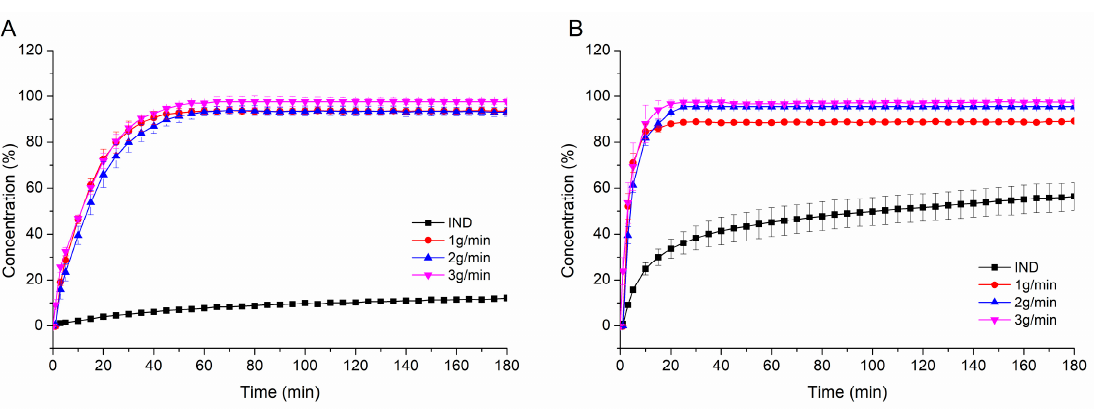
Figure 8. Non-sink dissolution of indomethacin (IND)-PVAP ASDs for different hot-melt extrusion (HME) process conditions at pH 5.5 ( A ) and pH 6.8 ( B ).